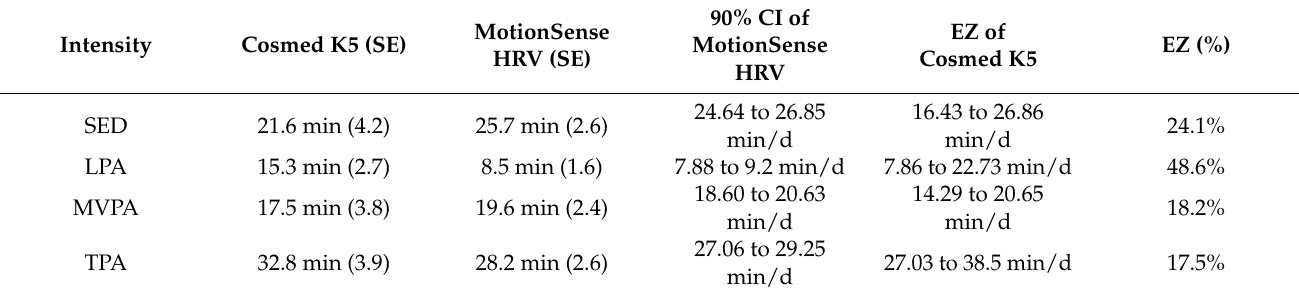
Table 6. 90% Confidence Intervals (CIs) from the MotionSense HRV and Equivalence Zones (EZs) from the K5 indirect calorimetry in simulated free-living